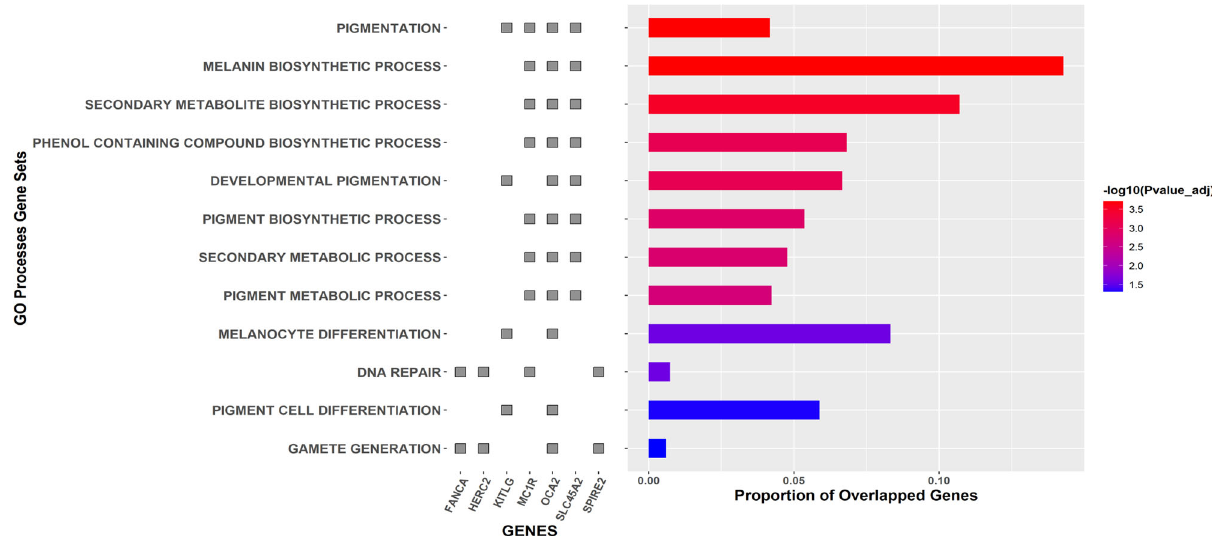
Fig. 3 Enrichment pathway analysis of genome-wide signi fi cant hair colour signals. Analysis performed with FUMA using Gene Ontology processes for all genes signi fi cantly associated with hair colour, as indicated by FINEMAP results ( n = 13